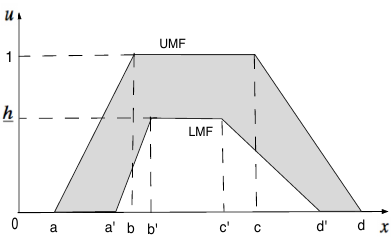
Figure 1. FOU for a trapezoidal IT2FS ˜ A